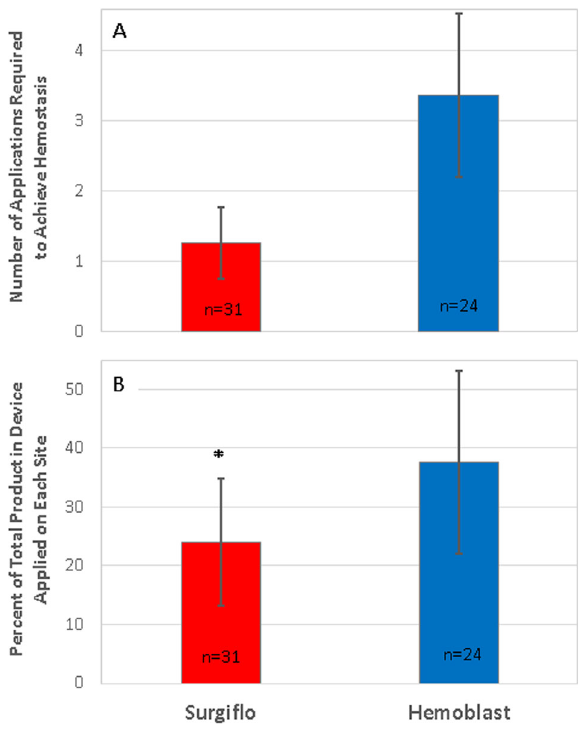
Fig. 6 Product application per site for sites that achieved hemostasis. A Average number of product applications required to achieve hemostasis. Hemoblast required more than twice the number of applications than Surgi fl o to achieve hemostasis (3.37 ± 1.16 vs. 1.26 ± 0.51). B Percent of total product per device applied on each lesion site. Surgi fl o-treated sites required less product per device to achieve hemostasis compared to sites treated with Hemoblast (24.1 ± 10.8 vs. 37.6 ± 15.5% of total product contained in device). Data expressed as mean ± SD. * p < 0.001